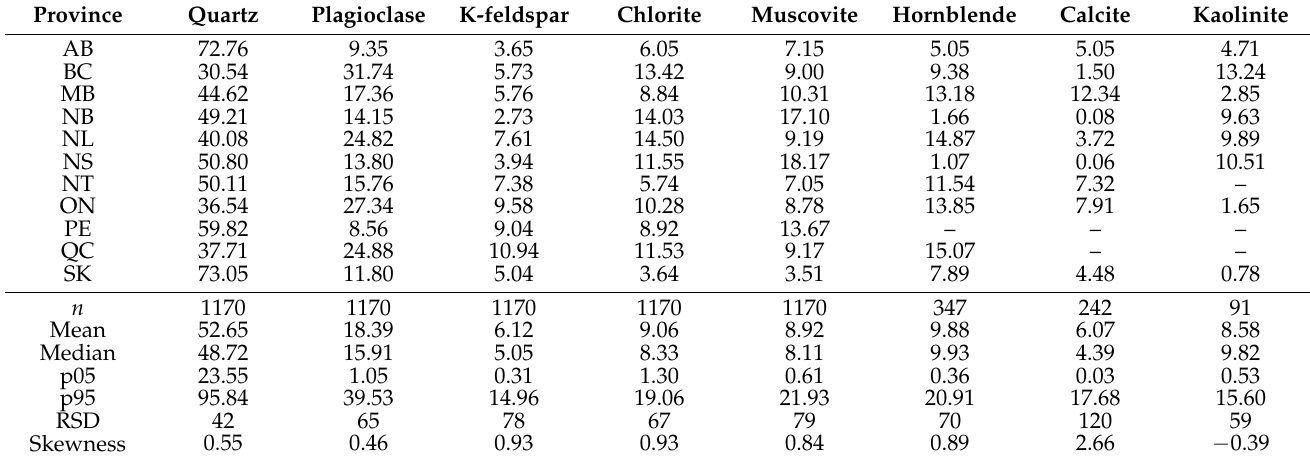
Table 4. Statistical summary of predicted mineralogy ( n = 1170; see Supplementary Material Data S2) from A2M (average solution) by province and territory (wt%). A summary across all study sites is also provided (p05 is the 5th percentile, p95 the 95th percentile, and RSD the Relative Standard Deviation).